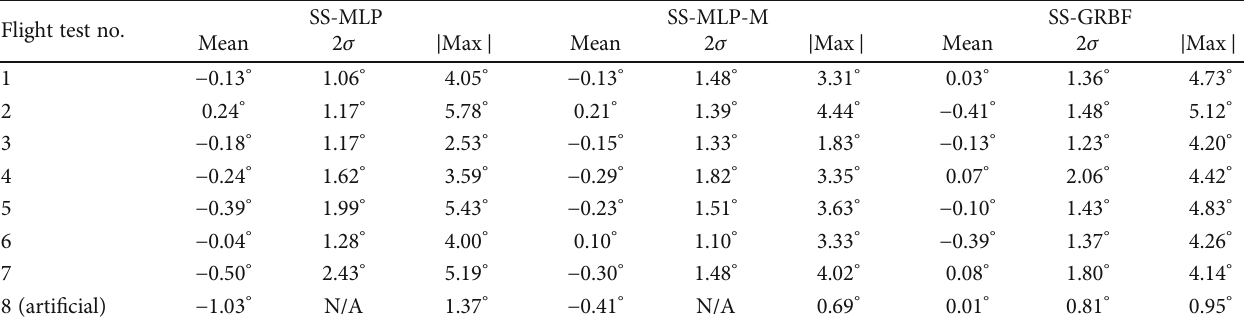
Table 3: Estimation error characteristics for MLP and GRBF networks. The 2 σ value is calculated as the error of the 95.45% of the data points. Flight test